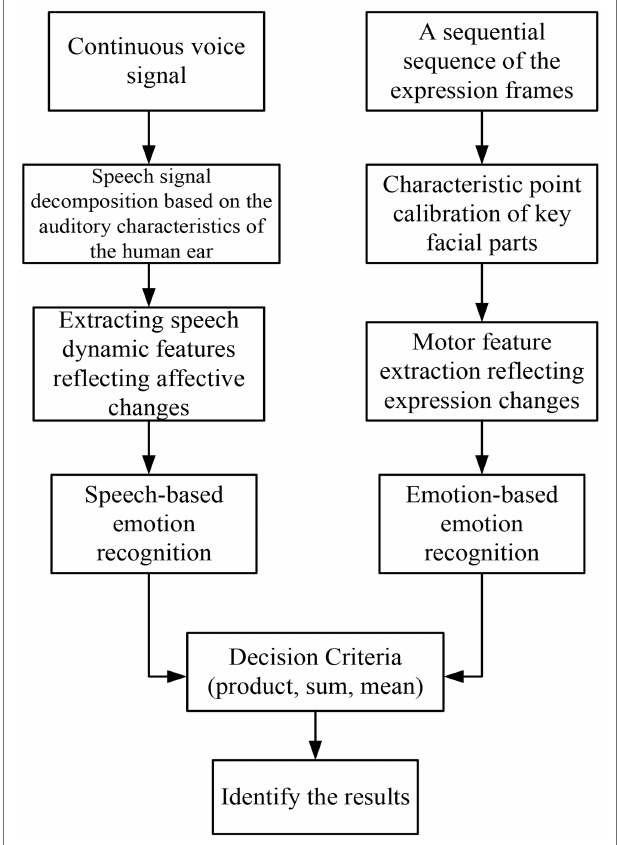
FIGURE 5 | Block diagram of multi-modal emotion recognition based on speech and